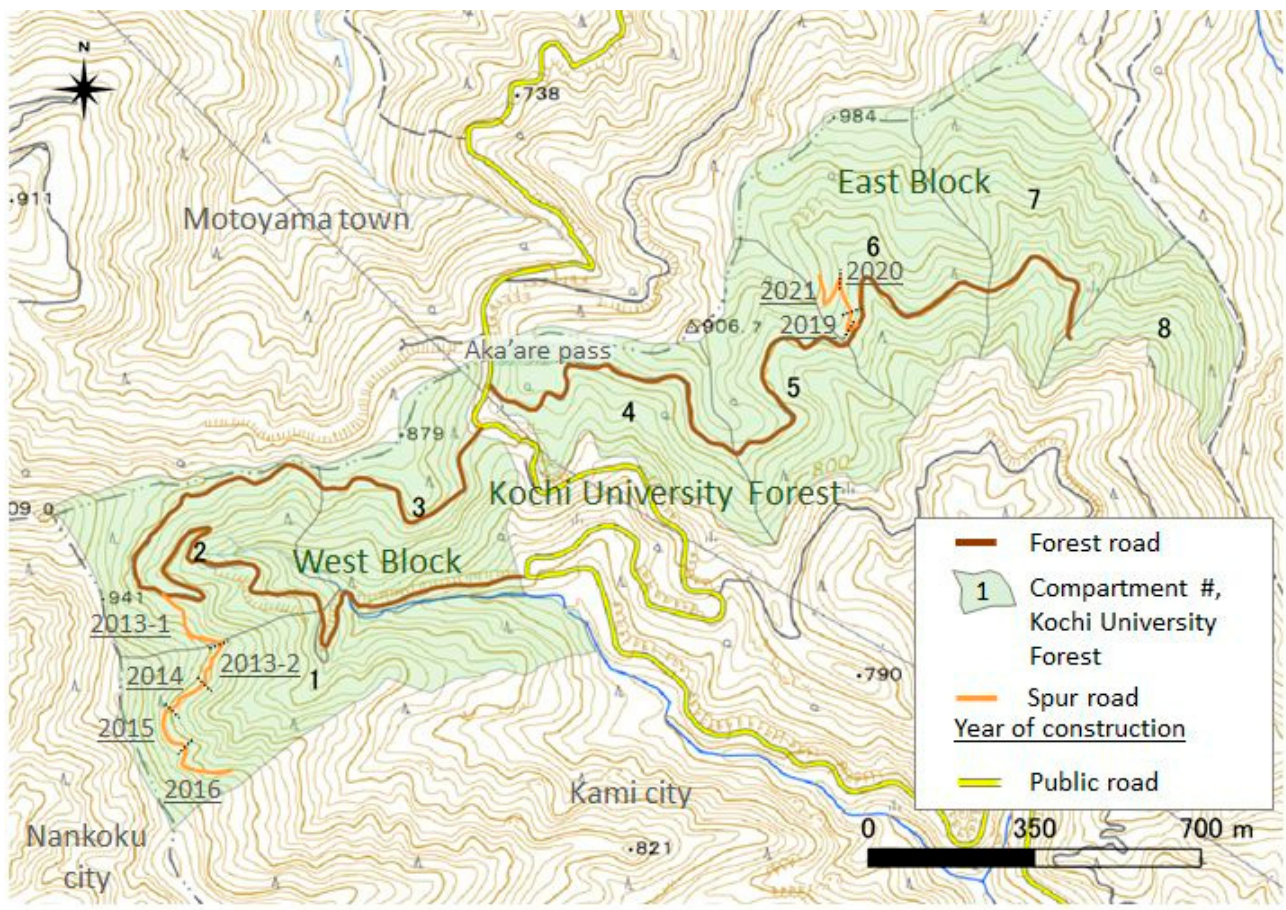
Figure 1. Study site. Site 1: A spur road constructed in FY 2013–2016 in the west block, Site 2: A spur road constructed in FY 2019–2021 in the east block of Kochi University Forest.